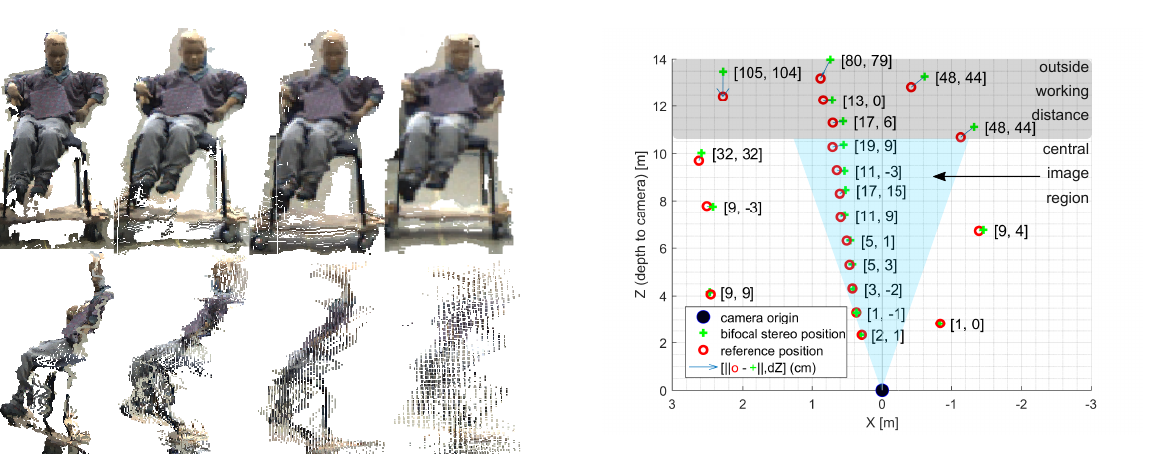
Figure 11. Visualization of the reconstructed 3D positions in a bird’s eye view, for 300 lux lighting. Points within the bluish Figure 10. Point clouds for 4,6,8 and 10m distance and 1000lux triangle are obtained from the central image region. lighting. The top row depicts four different distances to the camera in a front view. The second row shows the same point cloud from a side view.